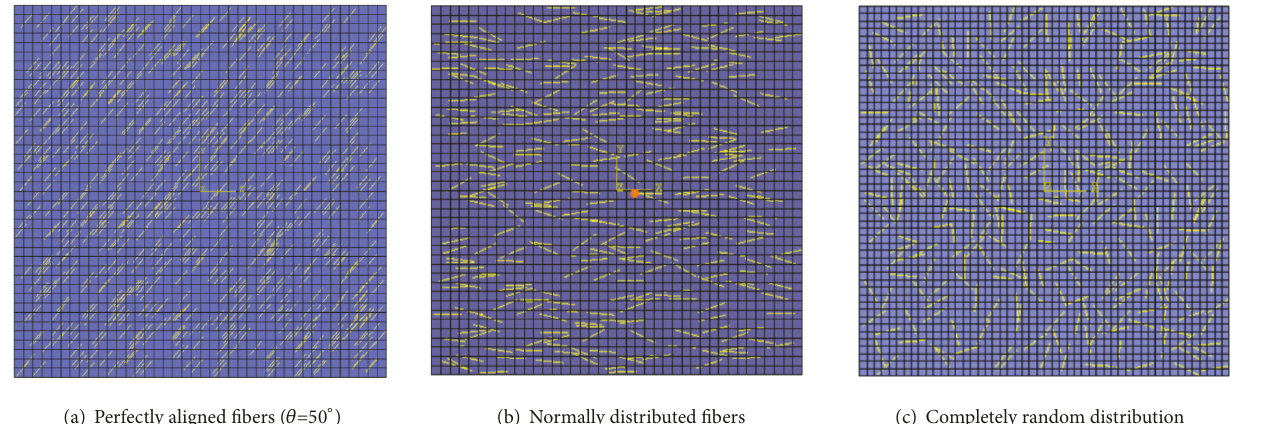
Figure 3: FE models for three fiber distribution types: D =20 mm, 𝑙 f =1